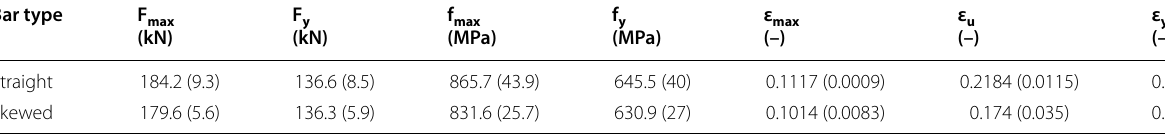
Table 3 Main parameters describing the mechanical properties of uncorroded bars.